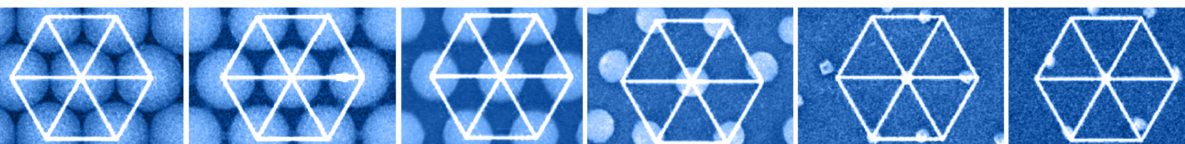
Figure 5. Schematic illustration of the reduction of the colloidal spheres dimension (with 0.5 µ m initial diameter) and increase of their spacing in the array, via low-frequency plasma etching, with increasing etching time (left to right). Adapted with permission from [60]. Copyright 2021